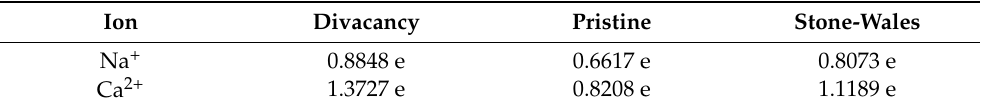
Table 4. Charge transfer for Na/Ca to graphene